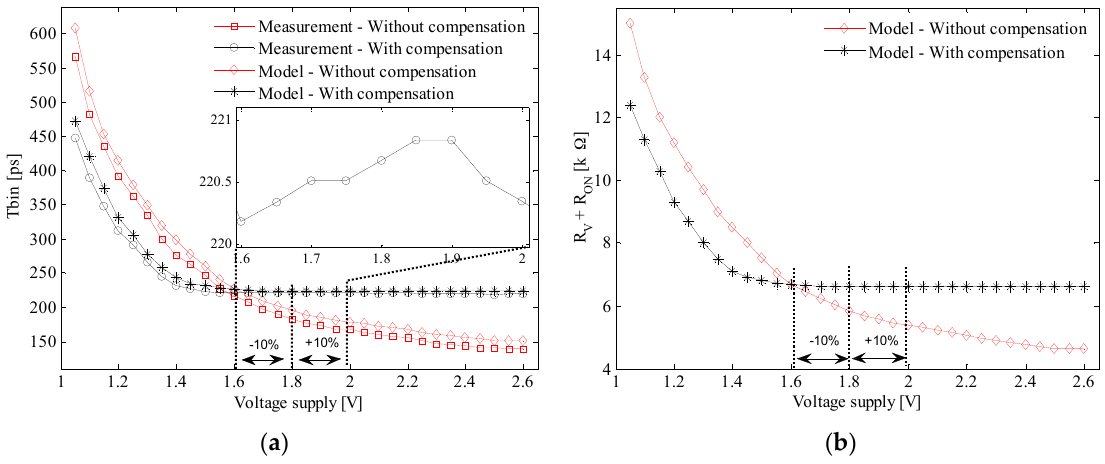
Figure 11. ( a ) Average T bin dependence on VDD: with compensation (model—asterisk marker; measurement—circle marker) and without compensation (model—diamond marker; measurement—square marker) ( b ) Equivalent resistance R V + R ON as a function of temperature: with compensated—asterisk marker; without compensation—diamond marker.